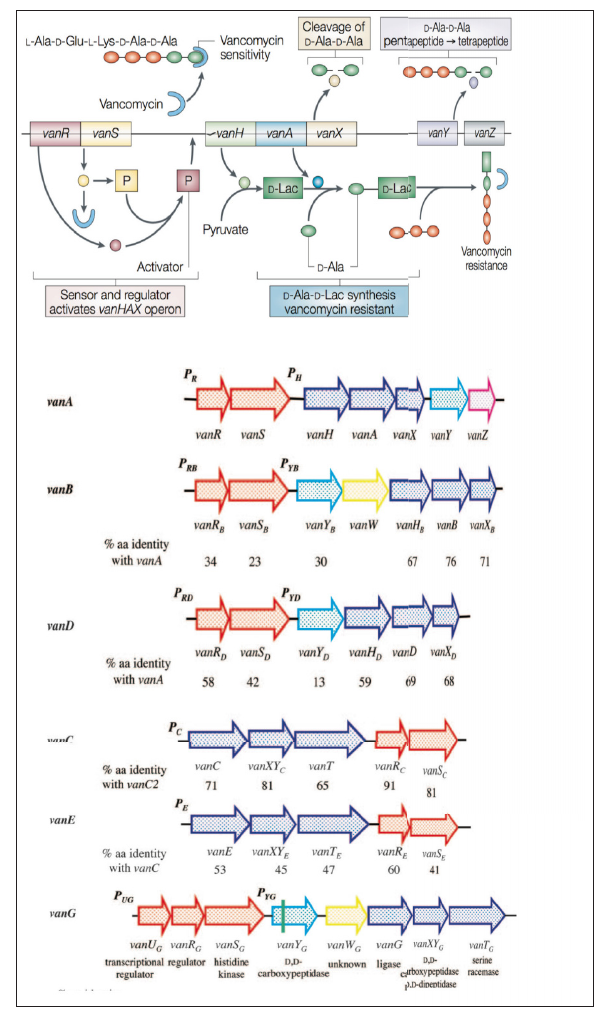
Figure 1: Vancomycin resistance gene clusters and resistance mechanism.